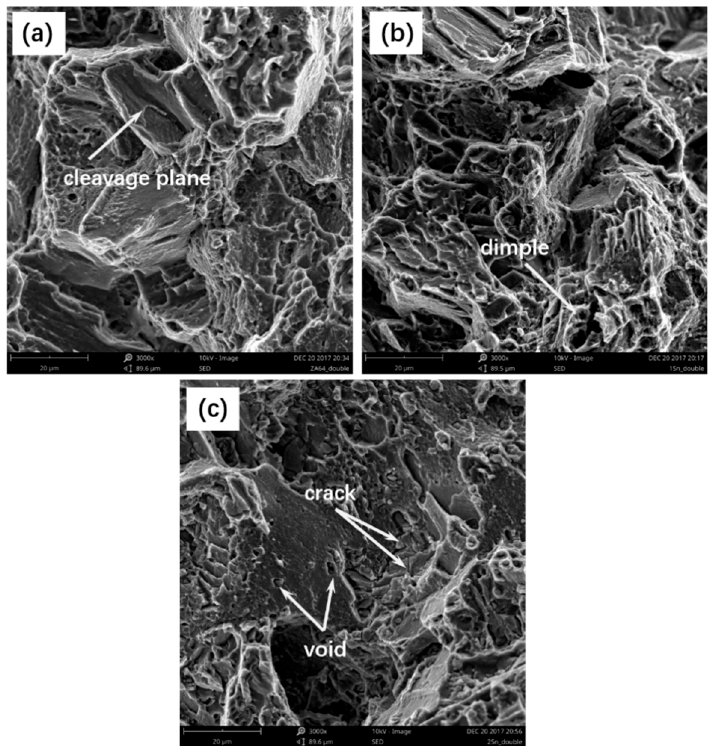
Figure 16. The SEM images of the tensile fracture surface of the double-peak aged alloys: ( a ) ZA64, ( b ) ZAT641, and ( c ) ZAT642.